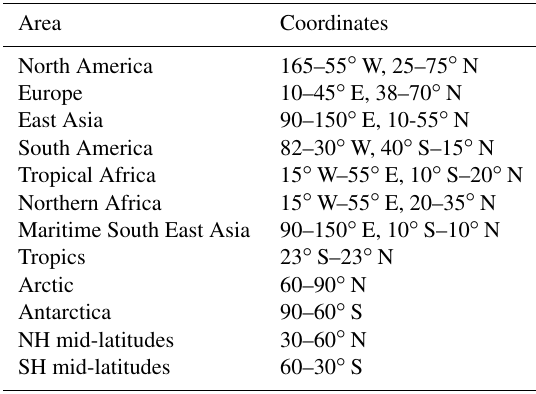
Table 3. Coordinates of